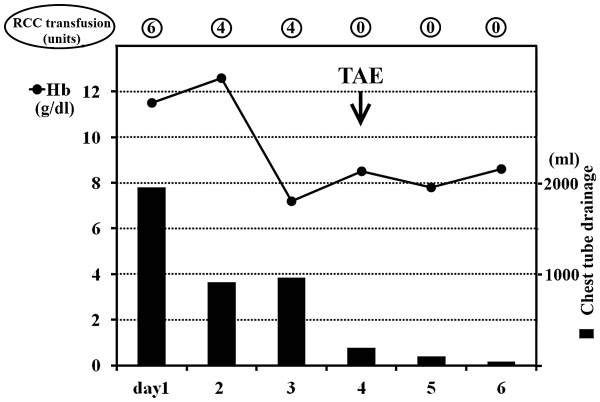
Changes in hemoglobin (Hb) (line graph) and the amount of the chest tube drainage (bar graph) following admission. The number of units of packed red blood cell concentrates (RCC) transfused per day is also indicated. TAE, transcatheter arterial embolization.